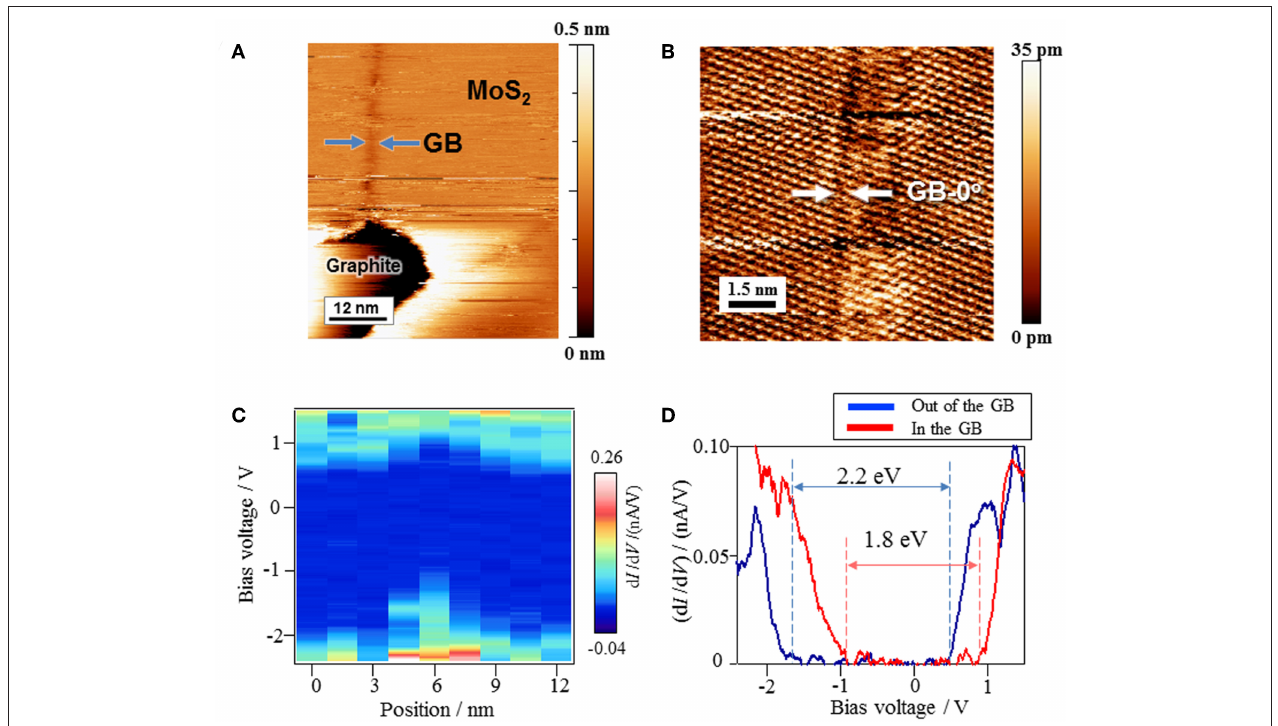
FIGURE 2 | (A) An STM image of MoS 2 grown on graphite. The blue arrows indicate the position of GB. (B) A magnified STM image around the GB-0 ◦ . The GB-0 ◦ can be imaged as a dark linear contrast, which are indicated by the arrow. (C) dI/dV mapping across the GB-0 ◦ . (D) STS spectra measured at a place out of the GB and on the